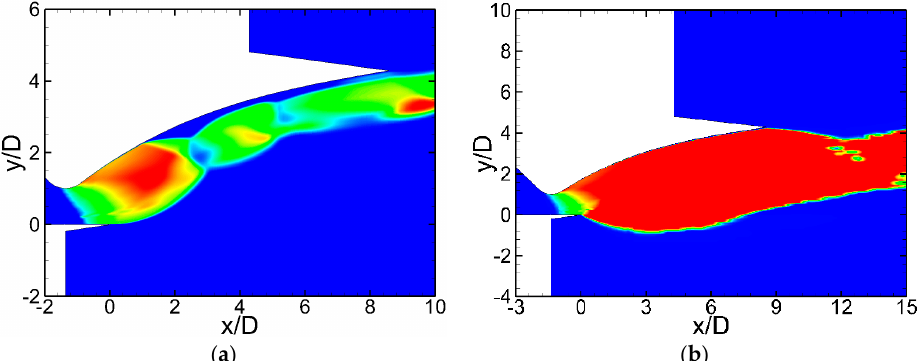
Figure 10. Typical contours of liquid mass fraction in wet steam flow. ( a ) p 0 = 7 bar, T 0 = 465 K; and ( b ) p 0 = 32 bar, T 0 = 527 K.